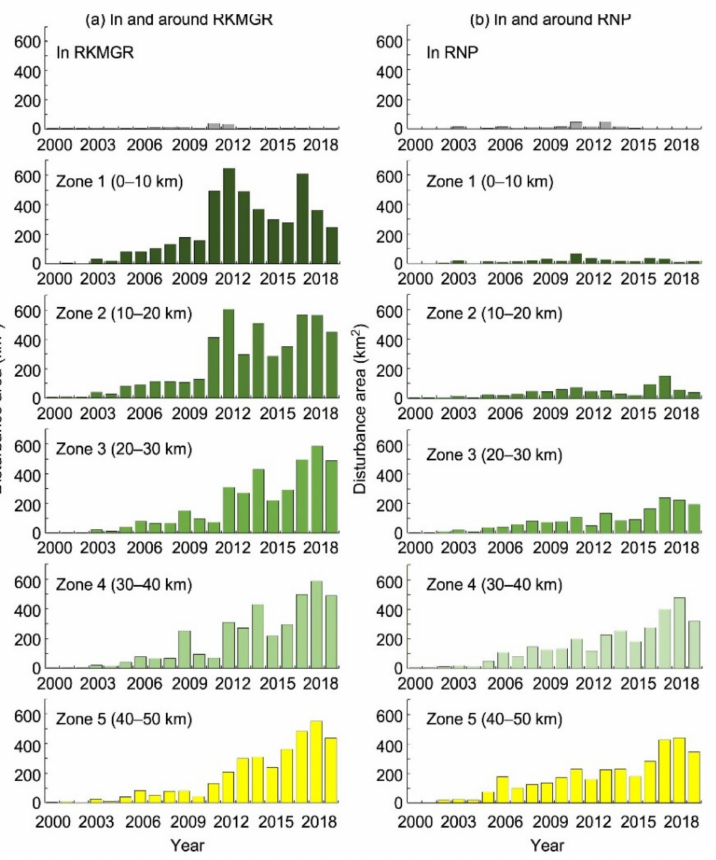
Figure 6. ( a ) Trends of the savannah disturbance area within the PA and in the five zones surrounding the RKMGR from 2000 to 2019; and ( b ) the trends in the savannah disturbance area within the PA and in the five zones surrounding the RNP from 2000 to 2019.